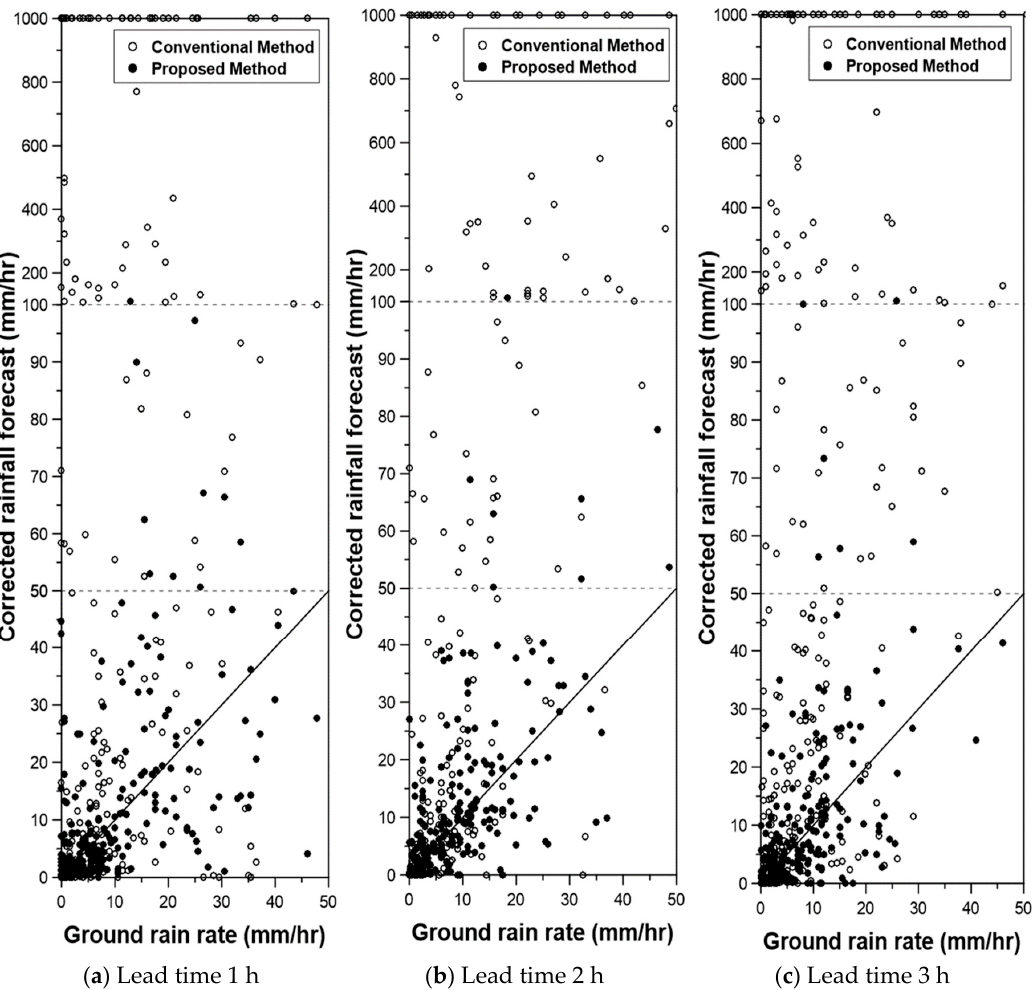
Figure 8. Comparison of corrected rainfall forecasts in the local window with the ground rainfall data ( a ) for the lead time of 1 h, ( b ) for the lead time of 2 h, and ( c ) for the lead time of 3 h. Table 3. Means and standard deviations (within the parenthesis) of bias correction ratio estimated for each storm event with respect to the lead time.